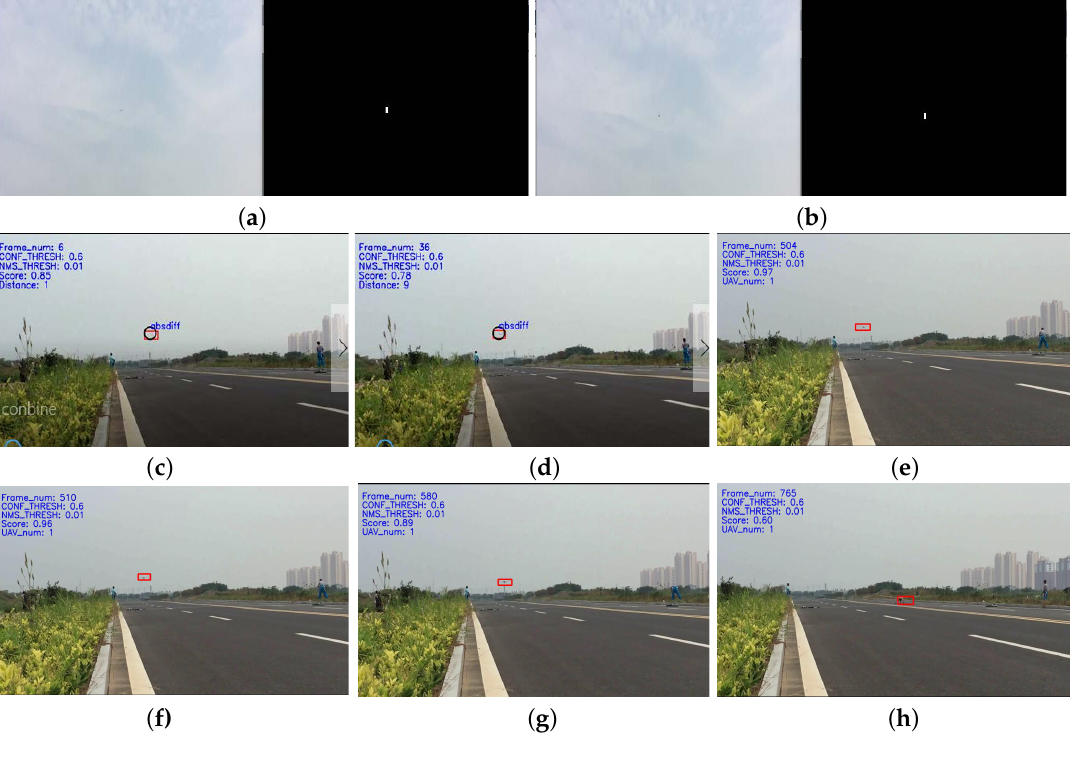
Figure 12. Images processed by the combined